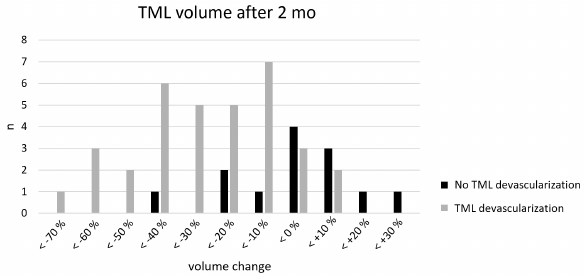
Fig. 3. Course of the true middle lobe volume (TMLVol) two month after the prostatic artery embolization (PAE). There is significant volume reduction of the TML after successful em- bolization with most cases presenting a 10–50% reduction. 29 out of 34 patients (85.3%) with successful TML devasculariza- tion showed a significant reduction of TML volume of greater than 10%. By contrast, without devascularization TML volume is al- most